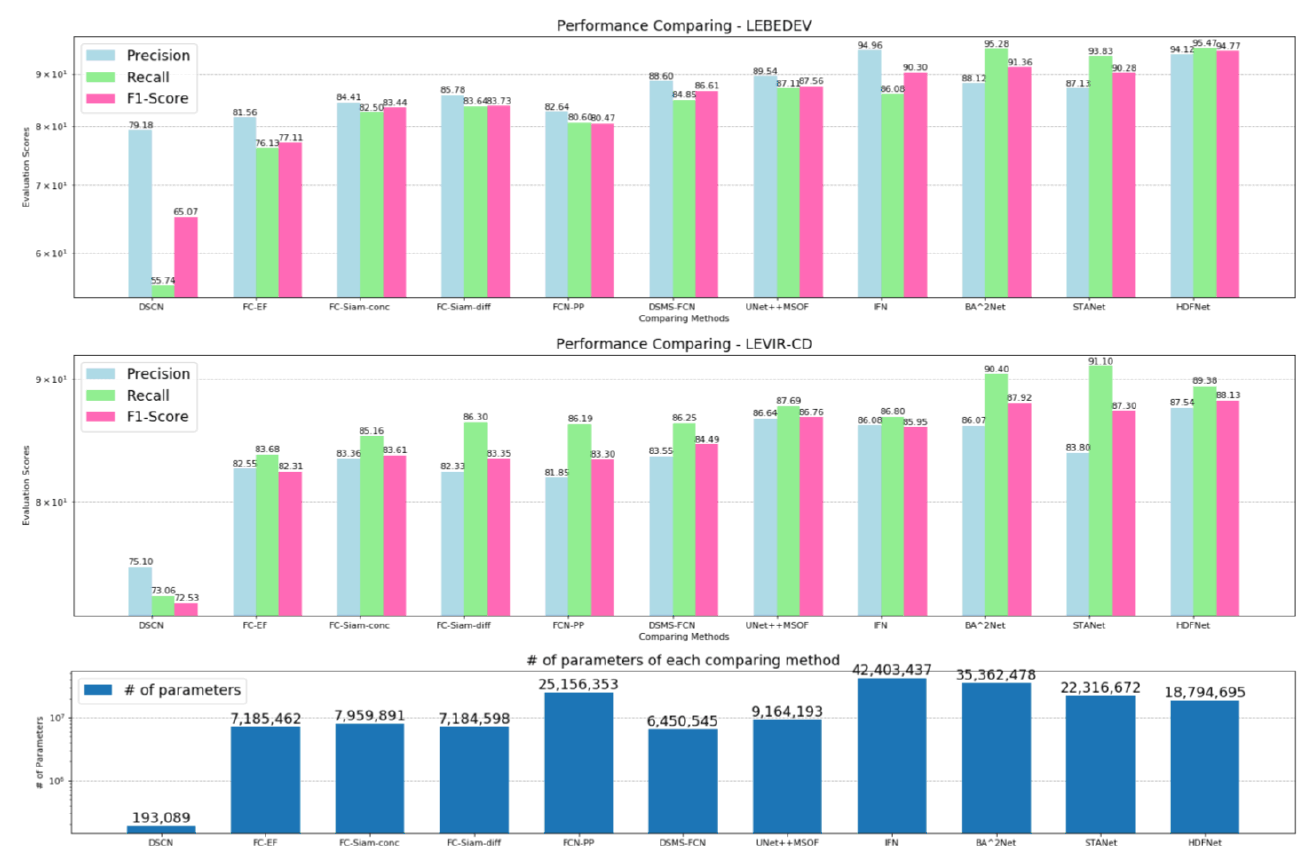
Figure 8. Summary of performance on datasets LEBEDEV and LEVIR-CD, with parameter numbers